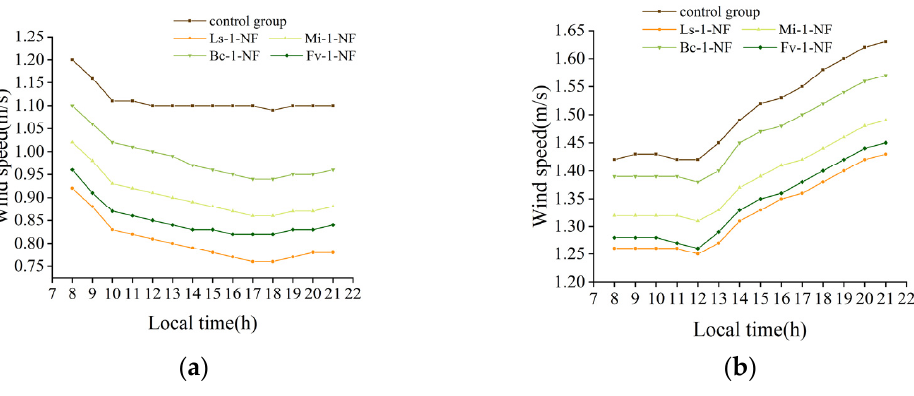
Figure 14. Effects of arbor species on wind speed in summer ( a ) and winter ( b ).